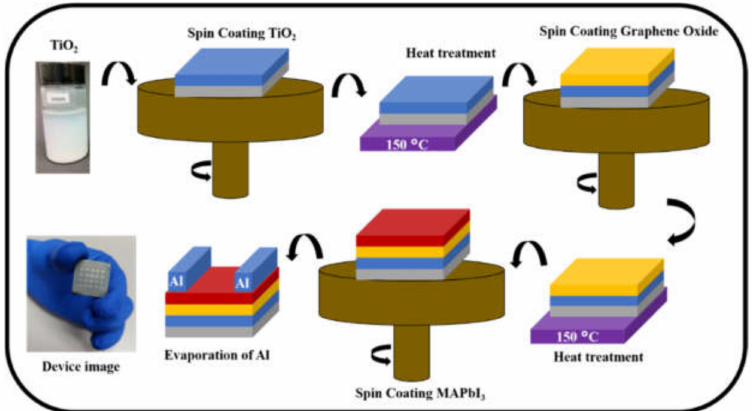
Figure 1. Schematic illustration of the device fabrication process and optical image of the fabri- cated